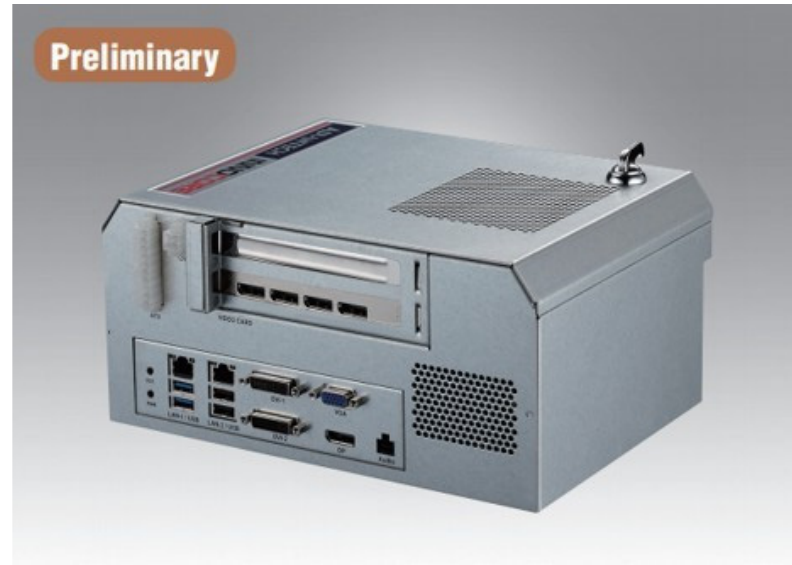
Figure 13. Advantech DPX-S1435 product (photograph courtesy of Advantech) [19].